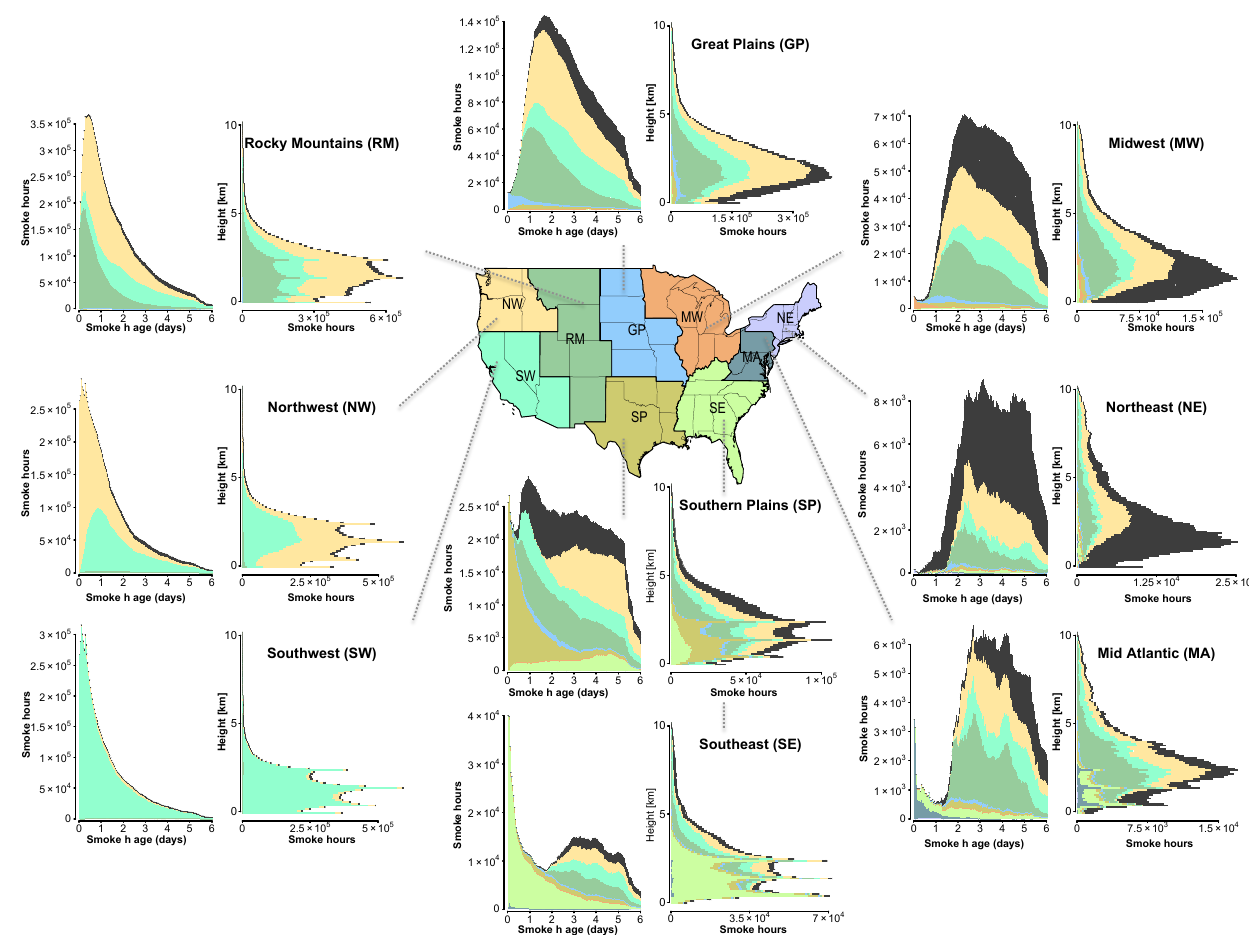
Figure 11. Summertime (June–September) regional smoke hour transport summaries for the nine continental US regions between 2007 and 2014 using GDAS1 meteorology. Two histograms are shown for each region. The histogram on the left shows the distribution of smoke hour age. The color of the smoke hours matches the region of origin as indicated by the map in the center. Column 2 shows the distribution of smoke hour height segregated by source region color. Smoke hours contributed by regions outside of the continental United States are dark gray. Histograms of smoke hour age, height, and region of origin for all regions shown in Fig. 6 are available in the Supplement.